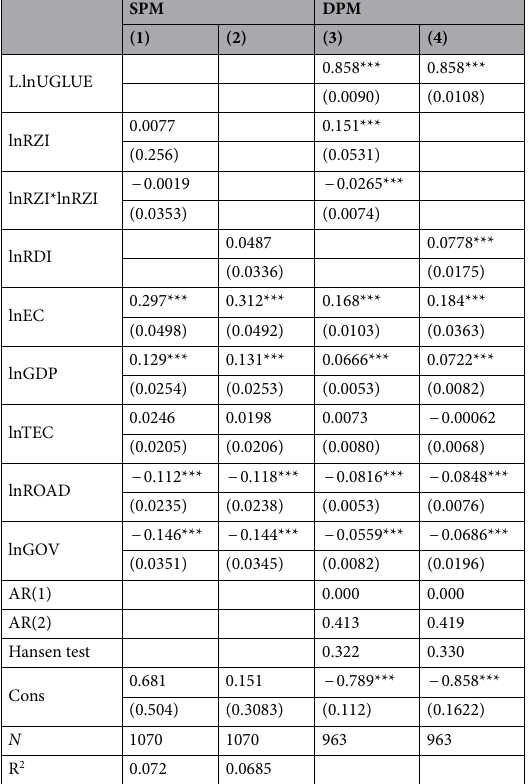
Table 3. Estimated results of SPM and